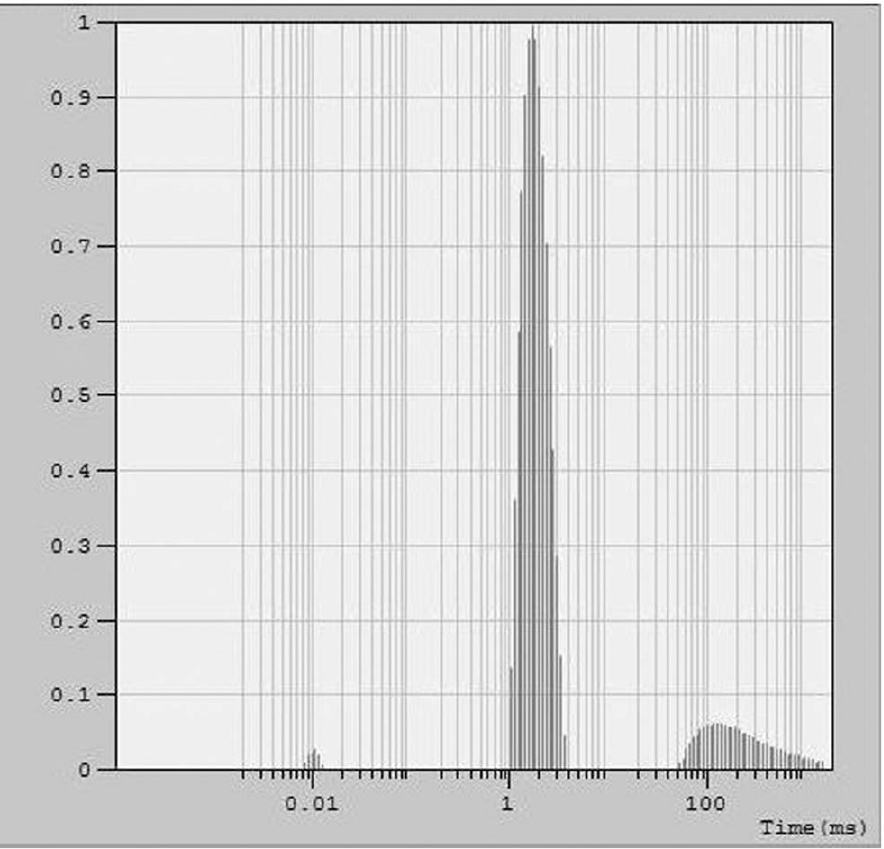
Figure 5. Dynamic Light Scattering of h 9 h 5 -vesicles. Distribution analysis of the data showing two major distributions centered around 1.68 ms and 119.4 ms and a mean correlation time of 1.85 ms and 275.7 ms respectively. These correlation times correspond to a hydrodynamic radius of 80 nm and 10 m m respectively.